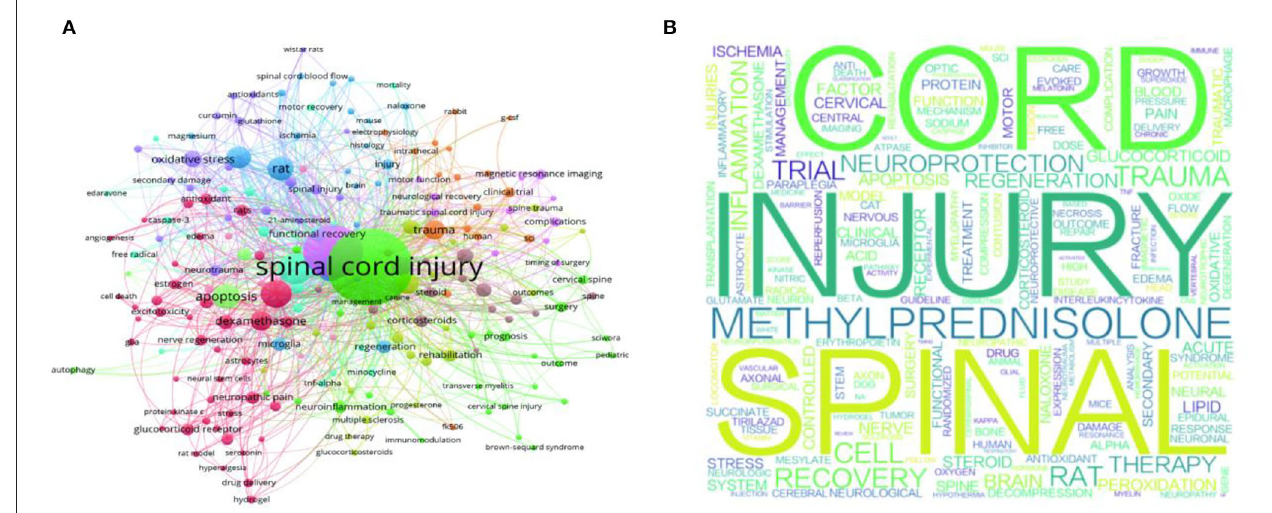
FIGURE 2 | Mapping on analysis of keywords in spinal cord injury and glucocorticoid publications. (A) Co-occurrence of keywords. (B) Word cloud. “spinal cord injury,” “MP,” “neuroprotection,” and “inflammation” occurred most